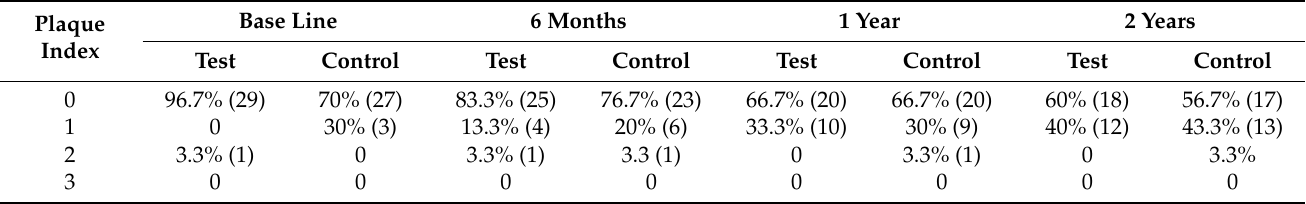
Table 4. Plaque index (PI) (%)